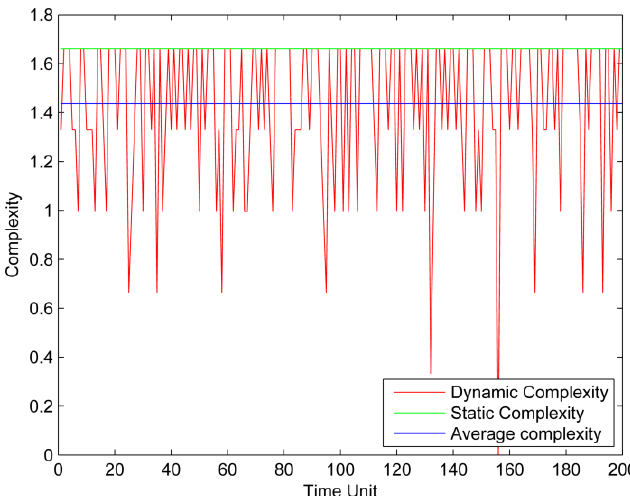
Fig. 2. Static, dynamic and average complexities in the Dining Chinese Philosophers problem.